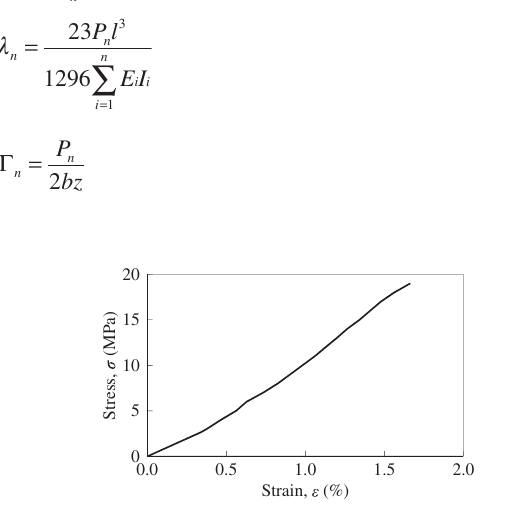
Figure 8 Stress-strain curves obtained from compressive test of concretes.